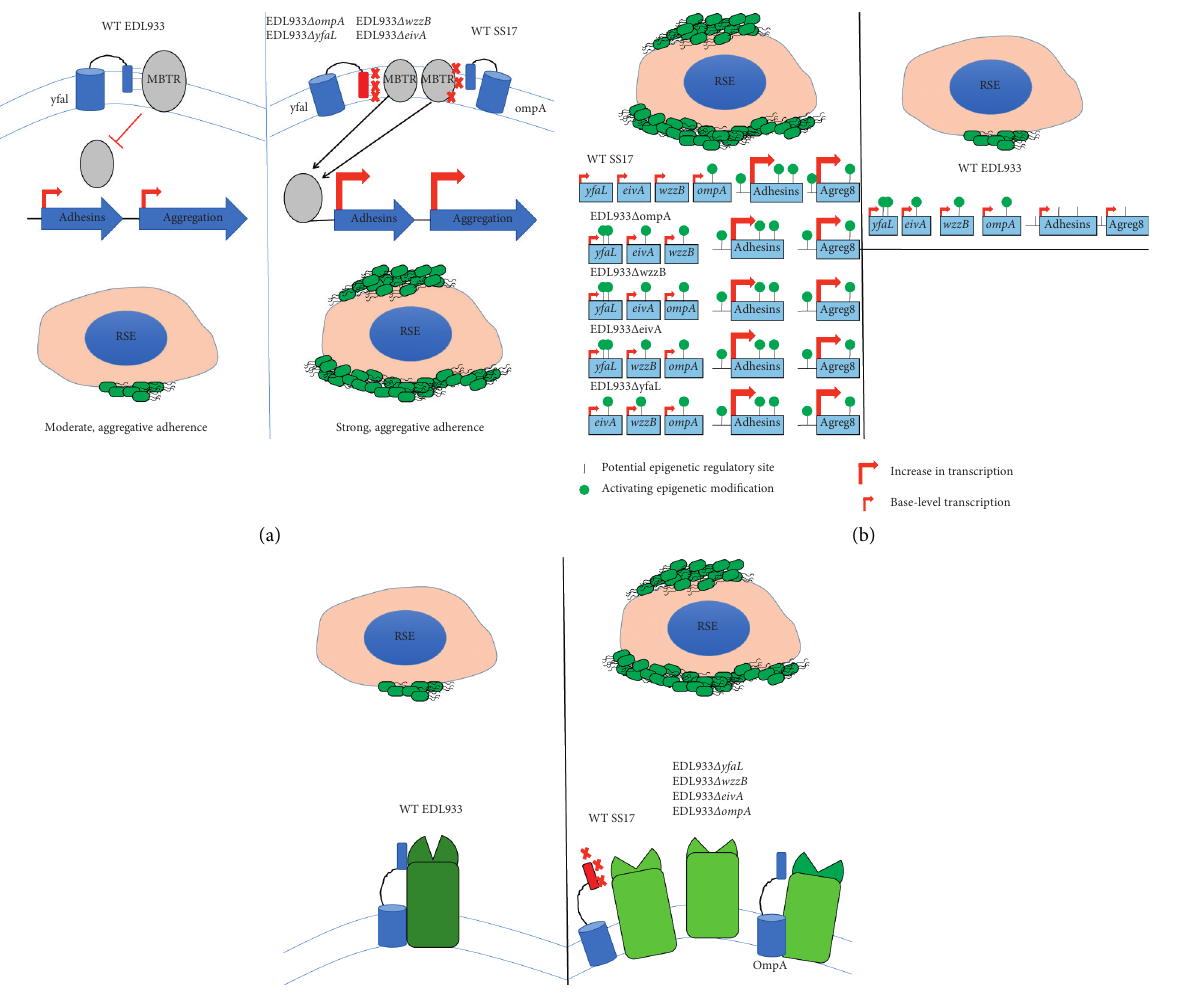
Figure 8: Proposed models driving SS-RSE adherence phenotypes. Based on our data from the EDL933 mutants and the SS17 SNP data, we propose the following models that begin to explain the unique adherence phenotype exhibited by SS isolates on RSE cells. At present, we